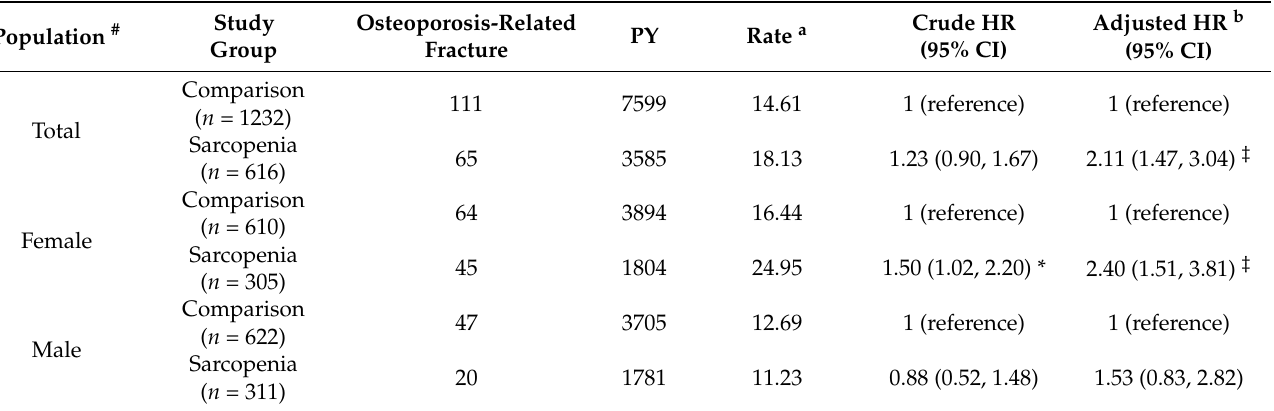
Table 2. Osteoporosis-related fracture frequency and HRs for osteoporosis-related fracture in both cohorts.